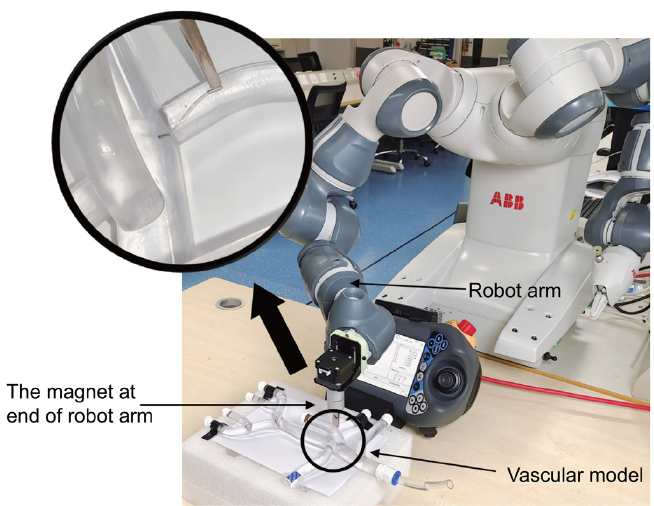
Figure 6. The MHCMM is moved to the perimeter of the target position by a permanent magnet fixed at the end of a robot